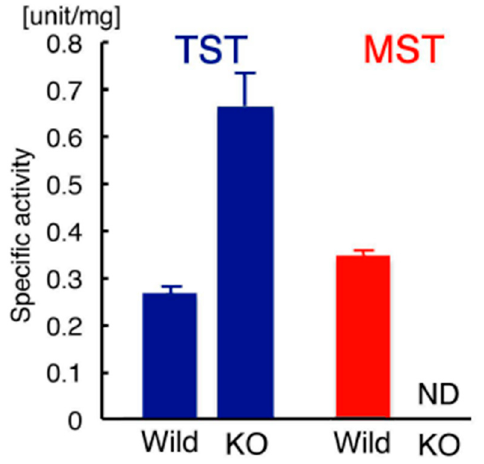
Figure 2. TST and MST activity assays in mitochondrial fractions. TST activity in KO mice was approximately 2.5 times more than the activity in wild-type mice ( p = 8.99 × 10 − 5 , n = 3). MST activity was not detected in KO mice. KO: MST-knockout mice; ND: not detected; Wild: wild-type mice.